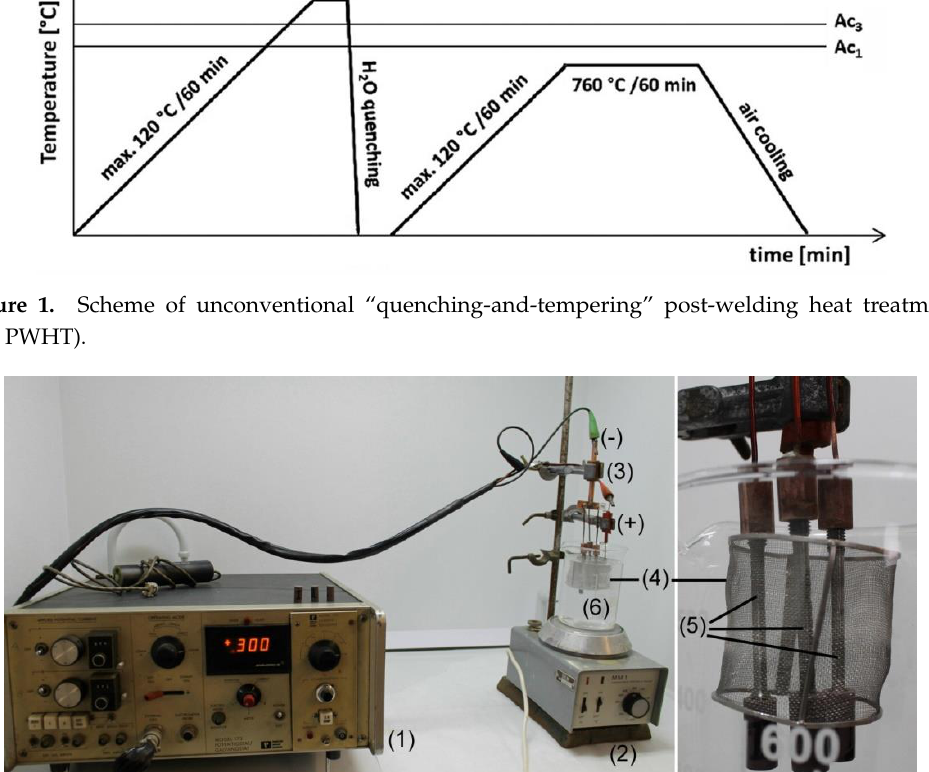
Figure 1. Scheme of unconventional “quenching-and-tempering” post-welding heat treatment (QT PWHT).